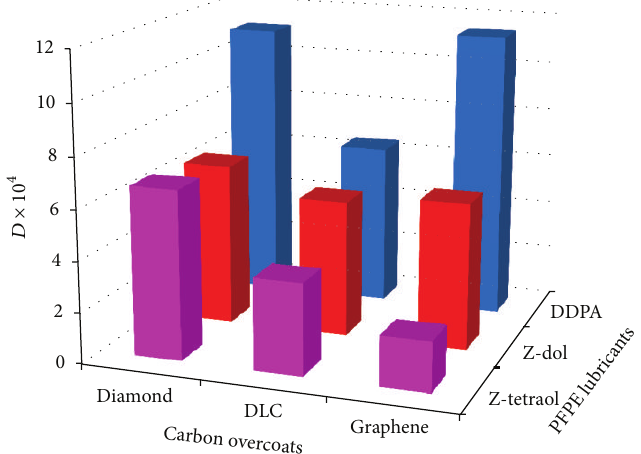
Figure 27: Parallel component of self-diffusion coefficients ( 𝐷 ‖ [𝜎 2 /𝜏] ) for each component of the material